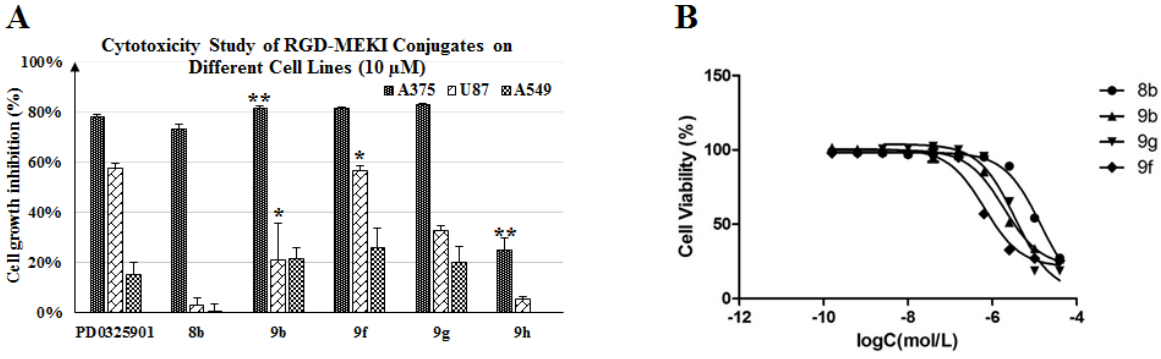
Figure 2. ( A ) Cytotoxicity study of RGD-MEKI conjugates 9b , 9f – h , compared with the parent drug (PD0325901) and MEKI— 8b on different tumor cell lines (melanoma-A375, glioblastoma-U87, NSCLC-A549) at 10 µM concentration by the SRB method. ( B ) IC value of 8b , 9b , 9f and 9g in A375 cells. The effect of cRGD peptide cargo on conjugates was analyzed by student’s t -test, and ( * ) indicates p value < 0.05, ( ** ) indicates p value < 0.01.